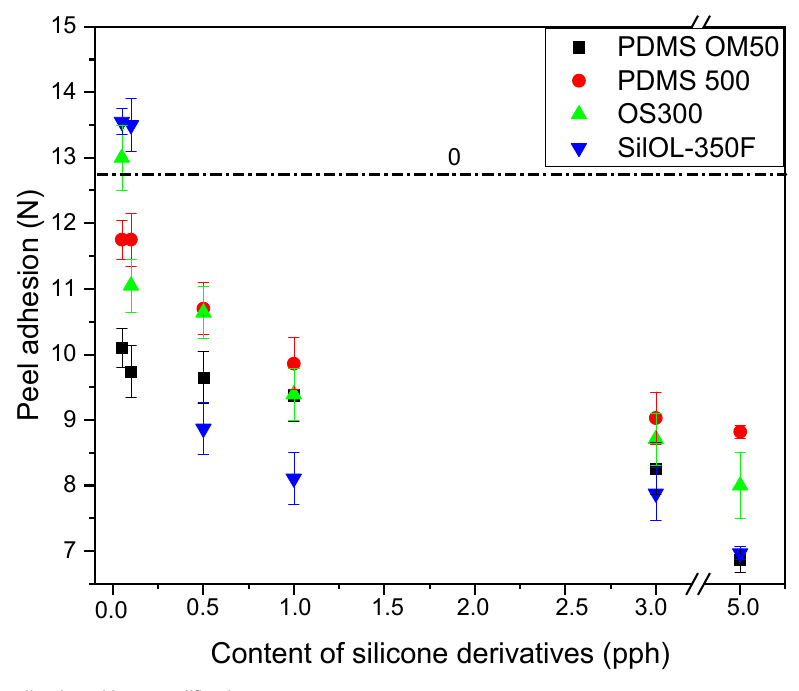
Figure 1. Effect of silicone derivatives addition on the peel adhesion of silicone pressure sensitive adhesives.